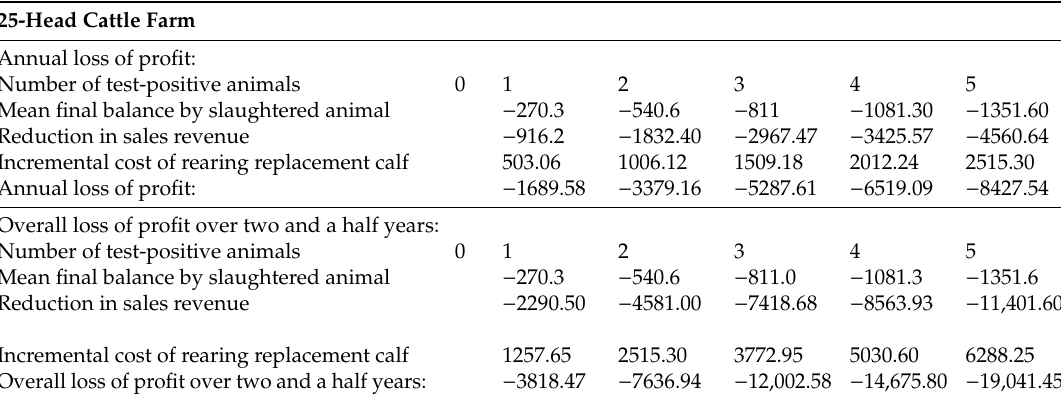
Table 9. Loss of profit on a farm with 25 head of cattle.